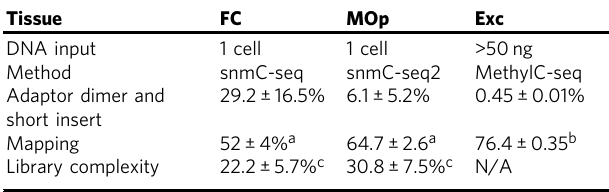
Table 1 Comparison of the quality of methylome libraries generated by snmC-seq, snmC-seq2, and MethylC-seq Tissue